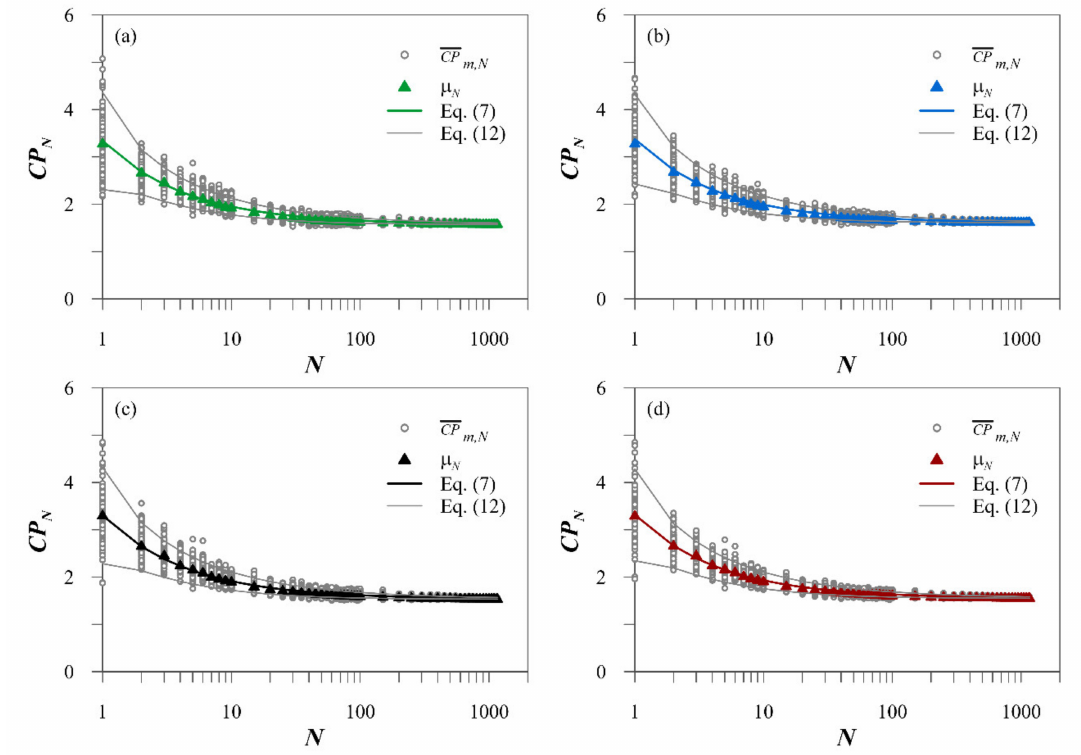
Figure 4. Sample means, expected values, and confidence bands as a function of the number of